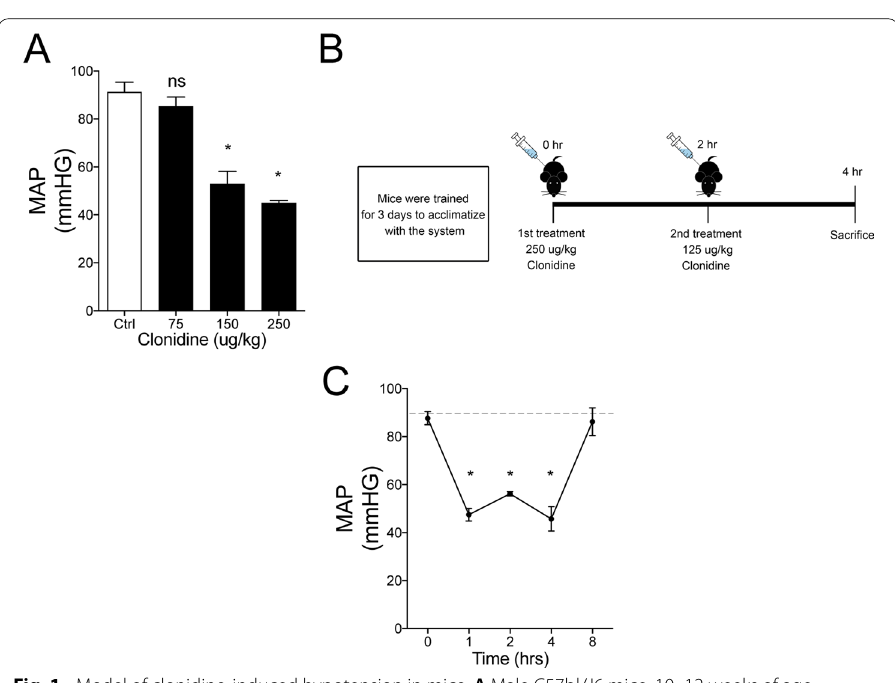
Fig. 1. Model of clonidine-induced hypotension in mice. A Male C57bl/J6 mice, 10–12 weeks of age, were treated with different clonidine concentrations to identify the concentration sufficient to drop the mean arterial pressure (MAP) by half after 2 h (* p < 0.05, ns not significant n 3 per group). B Schematic = = representation of the clonidine-induced hypotension protocol used for this study to maintain MAP below 60 mmHg over 4 h. C Mice were treated with 250 ug/kg and 125 ug/kg of clonidine at indicated timepoints to maintain a MAP below 60 mmHg for at least 4 h. At 8 h, MAP values were back to normal. (* p < 0.05, ns not significant, n 4 per group). The dotted lines represent the mean of saline-treated mice across the = =